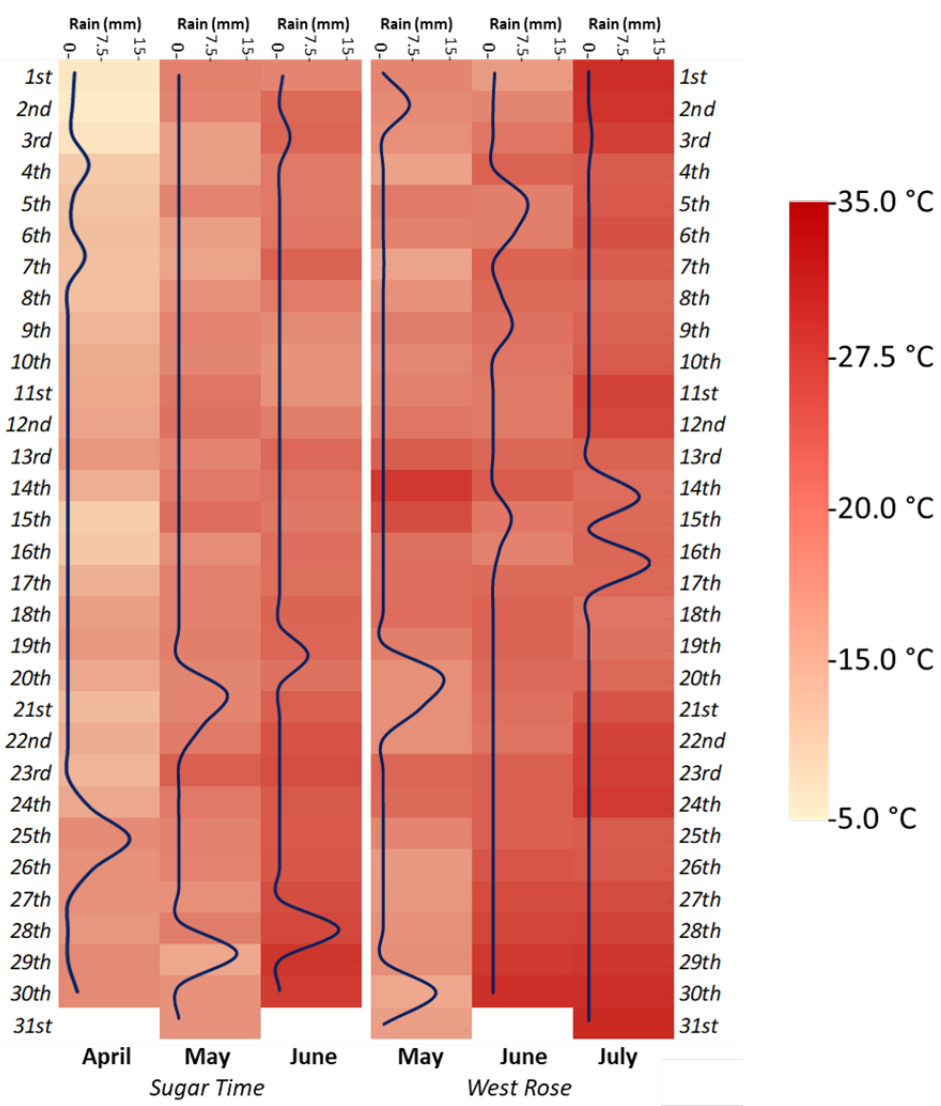
Figure 8. Environmental conditions recorded during the field trial in the two different experimental stations. The different colorings (yellow – red) indicate the different temperatures, expressed as Celsius degrees (°C). In addition, the blue line shows the amount of precipitation (mm per day) that occurred during the experimental months.